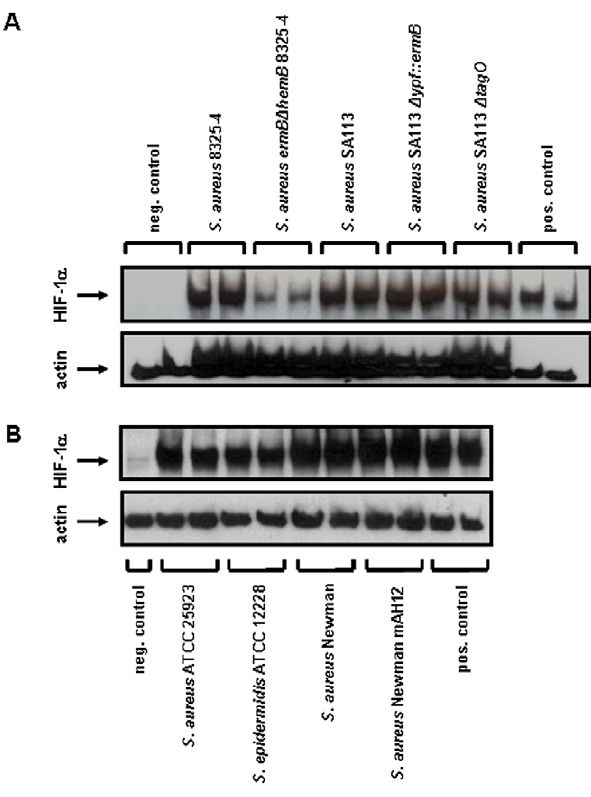
Figure 5. Induction of HIF-1 activation in HeLa-229 cells by different S.aureus strains defective in the expression of cell wall components. The HIF-1 a protein was analyzed in Western blots six hours upon infection (loading control: actin) of HeLa 229 cells with the following bacterial strains: (A) S. aureus 8325-4 (wt), S. aureus ermB V hemB 8325-4 (SCV), S. aureus SA113 (wt), S. aureus SA113 D ypf::ermB (reduced in lipoteichoic acid synthesis), S. aureus SA113 D tagO (defective in producing wall teichoic acid); (B) S. aureus ATCC 25923 (wt), S. epidermidis ATCC 12228 (wt), S. aureus Newman (wt), S. aureus Newman mAH12 (defective in producing the extracellular adherence protein EAP). Negative control: uninfected cells, positive control: DFO (200 m M). Multiplicity of infection (MOI):